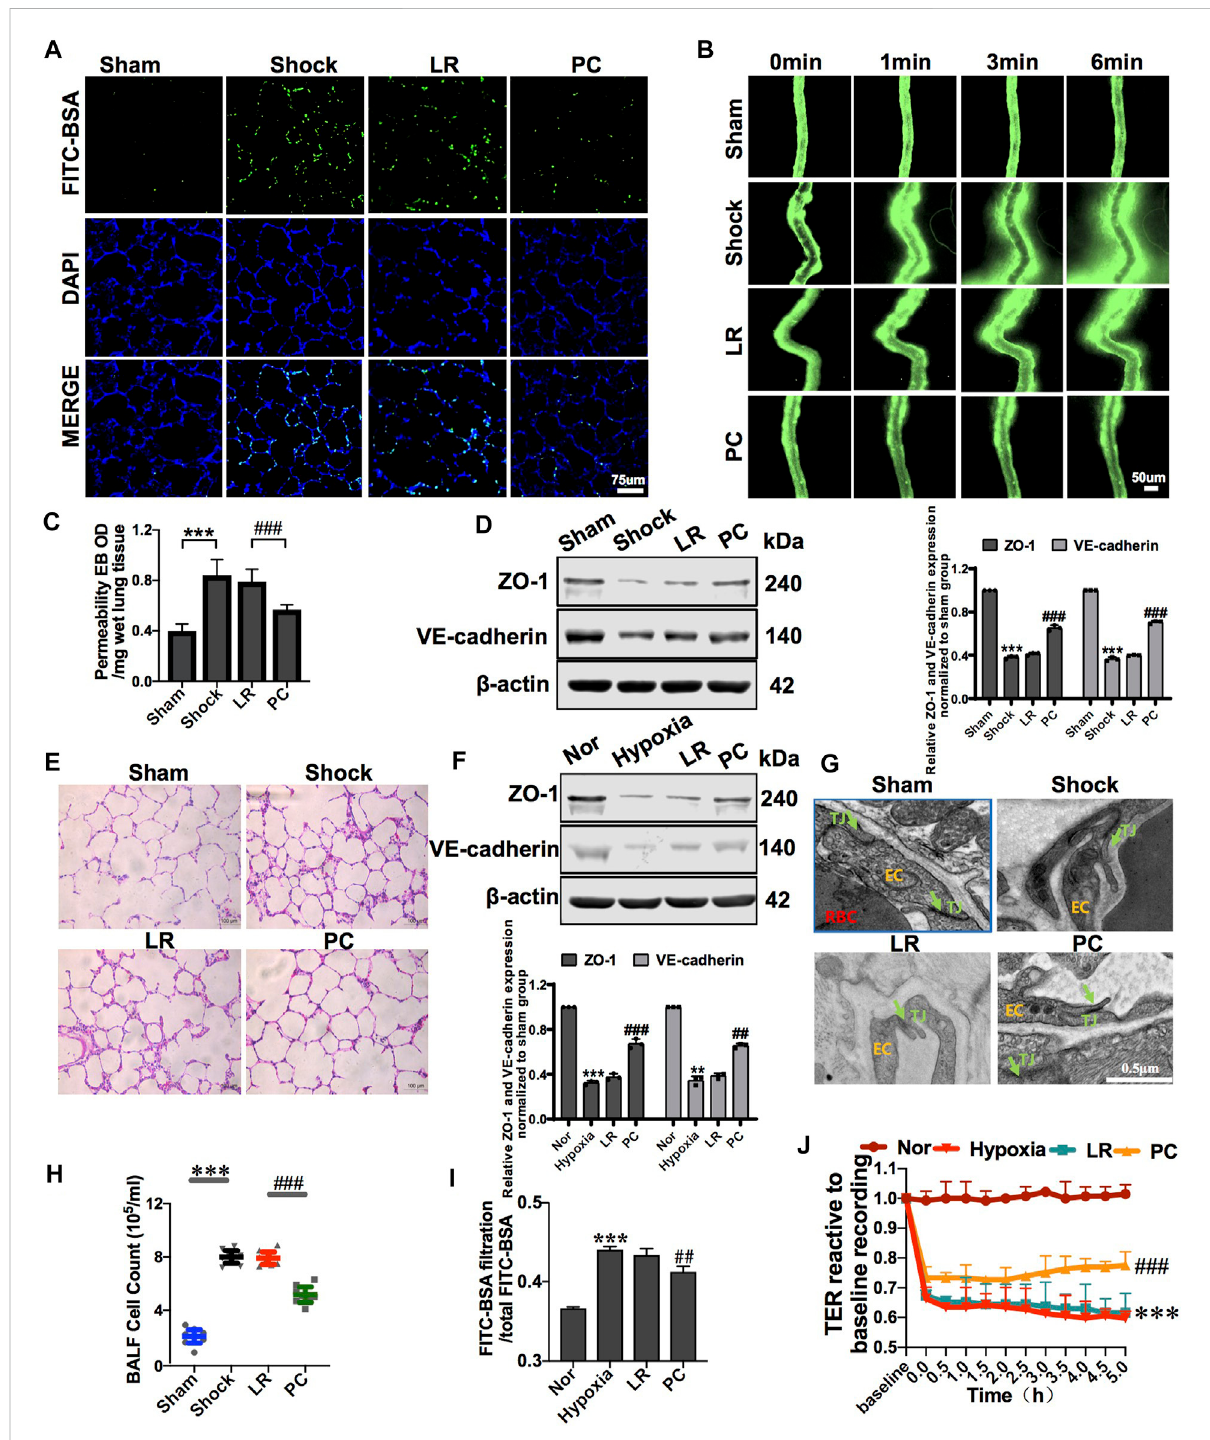
FIGURE 3 Exogenous PC infusion improved vascular barrier function and alleviated lung injury in hemorrhagic shock. (A) Effect of exogenous PCs on pulmonary vascular permeability determined by FITC-BSA ( n = 8). (B) Effect of exogenous PCs on mesenteric microvascular permeability determined by FITC-BSA ( n = 8mesentericmicrovesselsfromeightrats). (C) EffectofexogenousPCsonpulmonaryvascularpermeabilitydeterminedbytheEBleakageinlungtissue( n =8). (D) EffectofexogenousPCsontheexpressionofZO-1andVE-cadherininpulmonaryveinsdeterminedbyWB( n =12pulmonaryveinsfromthreerats). (E) EffectofexogenousPCsonthein fi ltrationofin fl ammatorycellsinthealveolarspaceafterhemorrhagicshockobservedbyHEstaining( n =8). (F) Effectof PCsontheproteinexpressionofZO-1andVE-cadherininVECsafterhypoxiadeterminedbyWB( n =3). (G) EffectofexogenousPCsontightjunctionstructure of VECs observed by TEM ( n = 32 pulmonary veins from eight rats). (H) Effect of exogenous PCs on the amount of cell in BALF after hemorrhagic shock ( n = 8rats/group). (I) EffectofPCsonFITC-BSAleakageofVECsafterhypoxia( n =3). (J) EffectofPCsontheTERofVECsafterhypoxia( n =3).** p < 0.001and*** p < 0.001 compared with the sham group (one-way ANOVA). ## p < 0.001 and ### p < 0.001 compared with the LR group (one-way